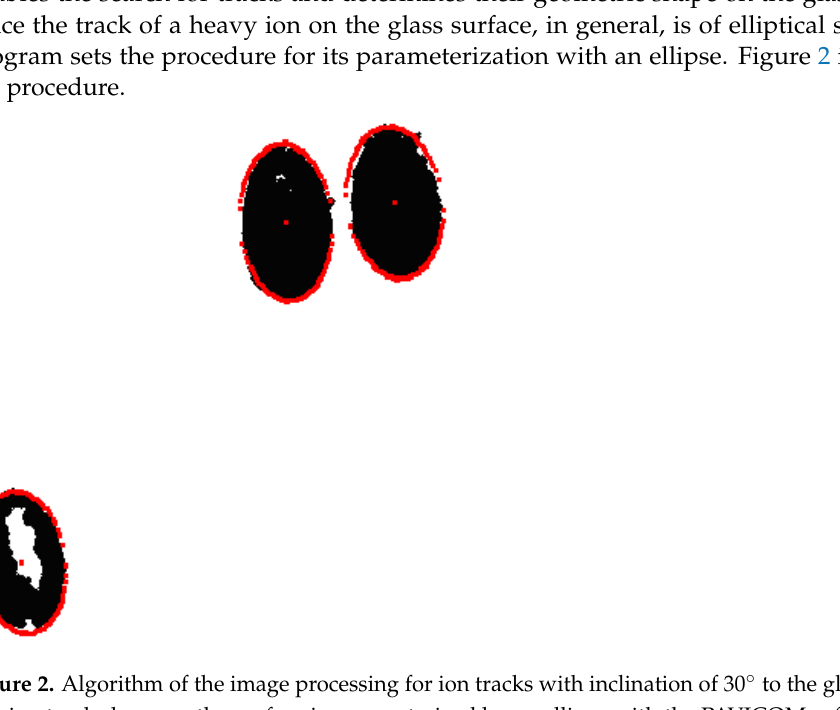
Figure 1. The shape of the 132 Xe 26+ ion tracks after etching in 40% HF for different etching depths (indicated under the images): ( a ) vertical entry, ion energy E = 65 – 68 MeV (the etching duration is given); ( b ) entry at 30° and 45° to the normal to the glass surface, ion energy E = 160 MeV; the etching duration is 5 min (No color).